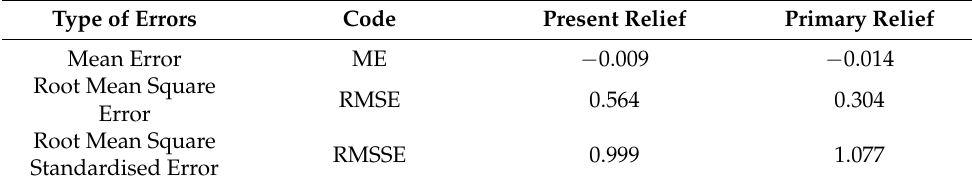
Table 3. Cross-validation (CV) error values.